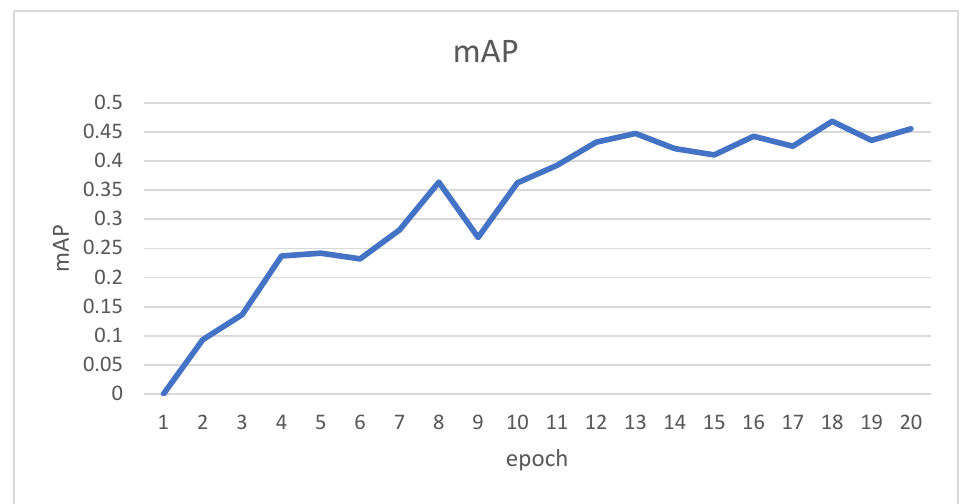
Figure 13. mAP accuracy curve of the Pest R-CNN model on test dataset for each epoch.